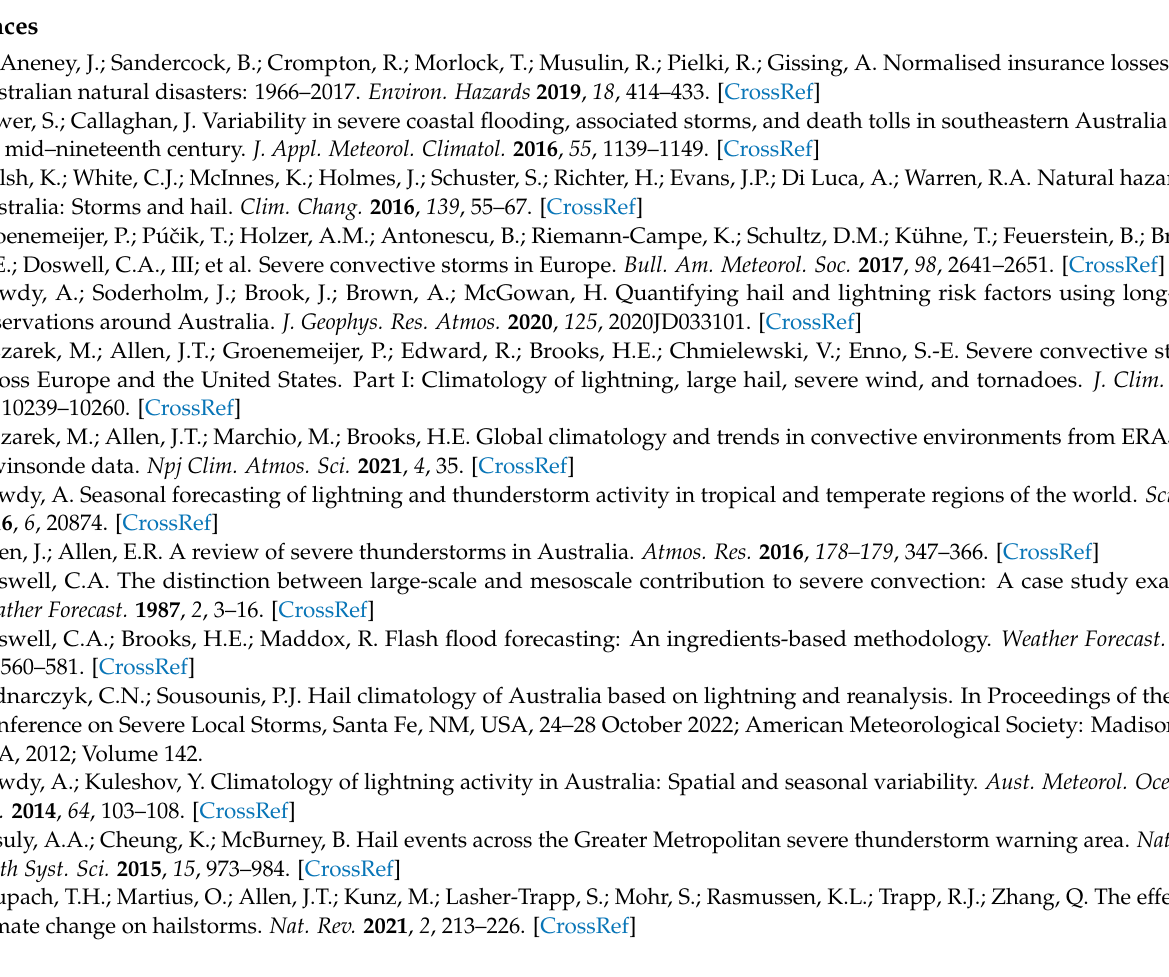
Figure A26. As in Figure A22 except for the NARCliM (d02) domain.